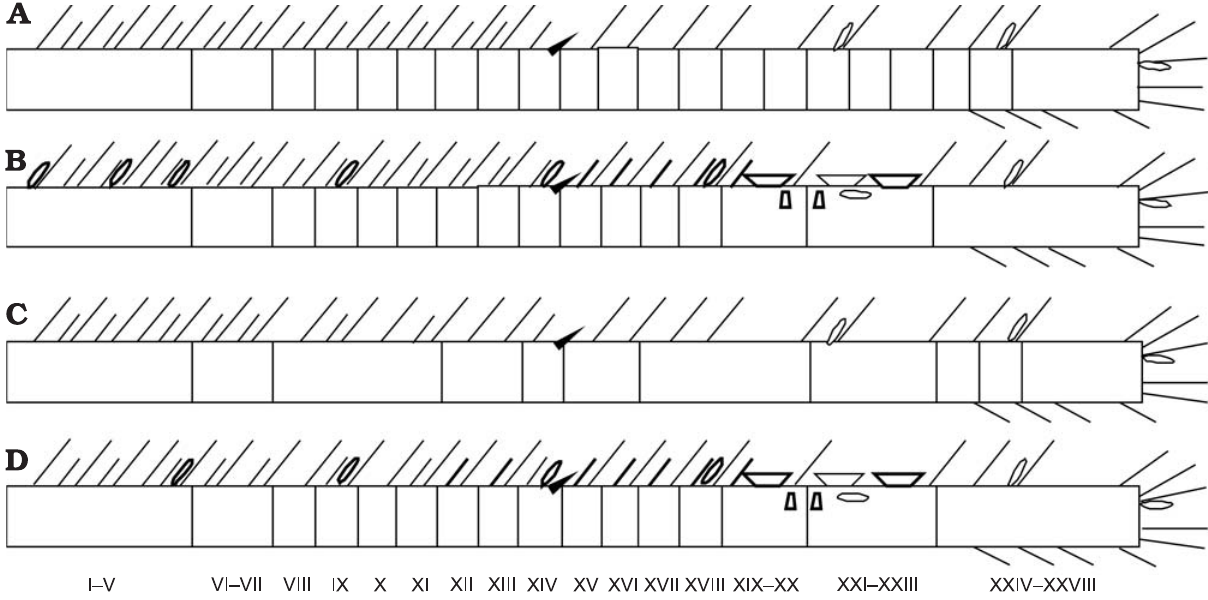
Fig. 9. Schematic representation of the antennule segmentation and setation in Cyclopidae. A , B . Euryte robusta . C , D . Apocyclops panamensis . Female (A, C), male (B, D). Symbols: short line, anteroproximal seta; long line, anterodistal seta; ellipse, aesthetasc; filled black triangle, spinous seta on segment XIV; trapezoids, modified setae. Structures indicated with thick lines are present in the male but not expressed in the conspecific female. Roman numerals denote the ancestral segment homologies in the male of A. panamensis